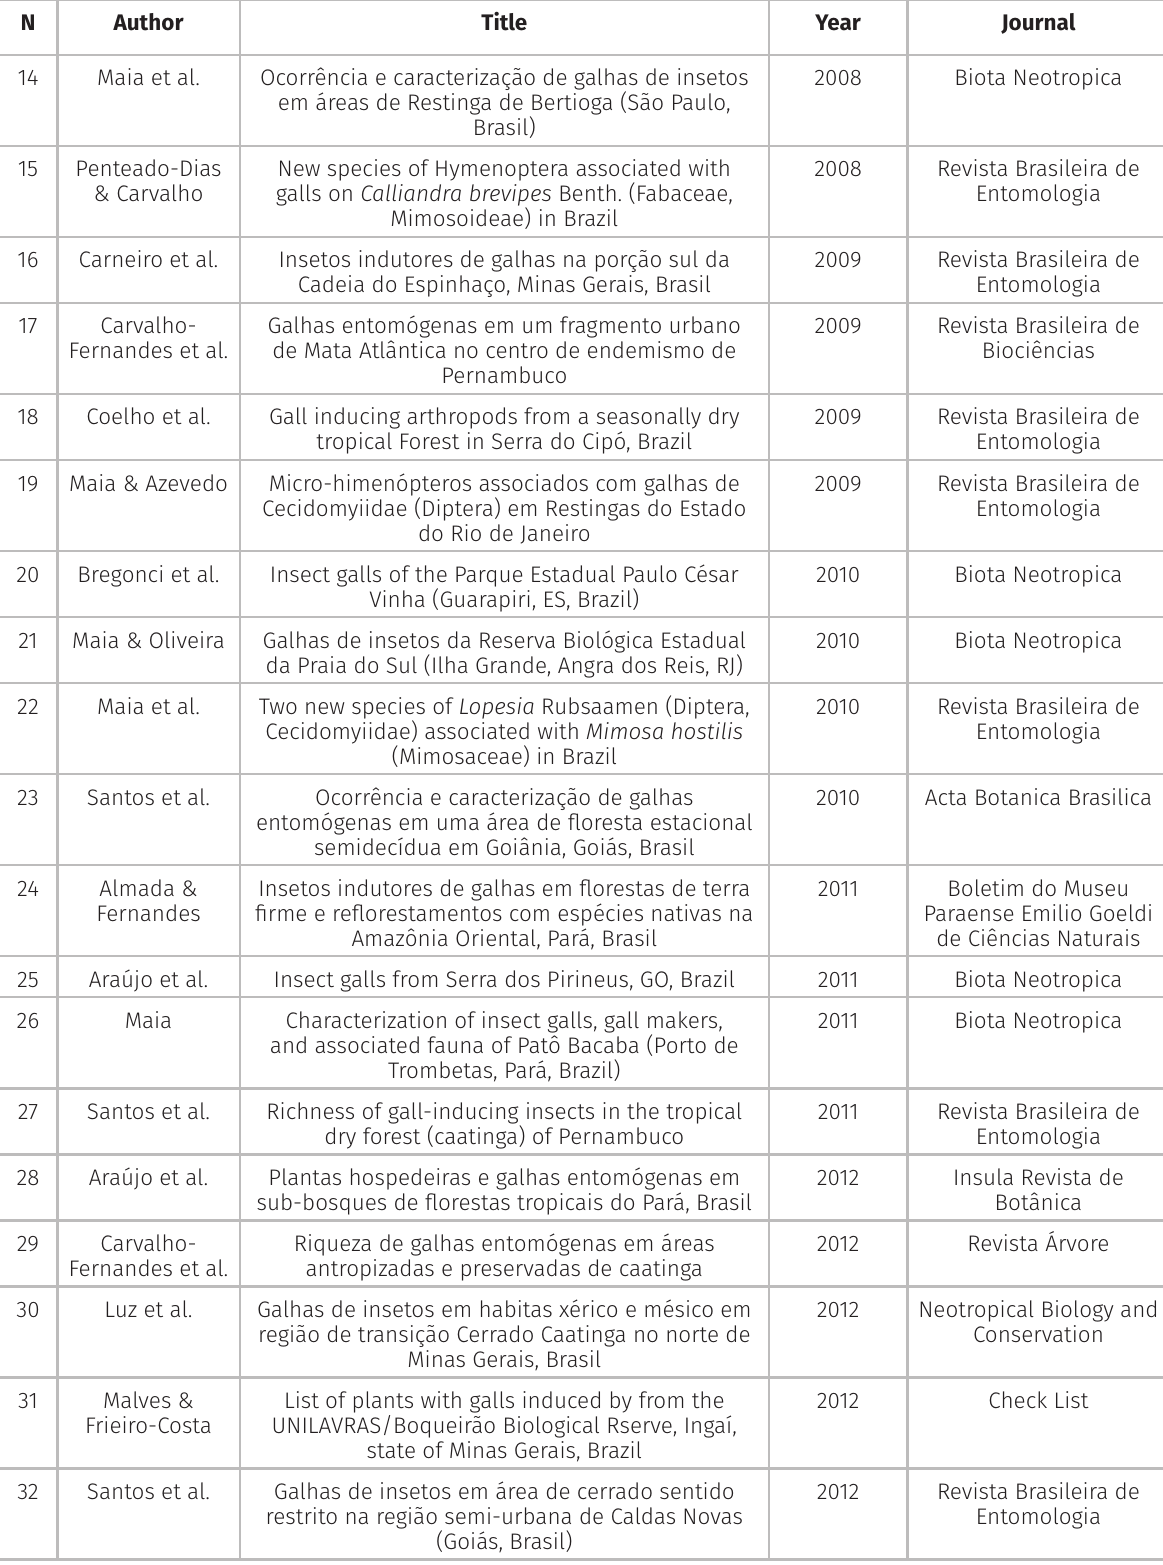
Table I. (continuation)